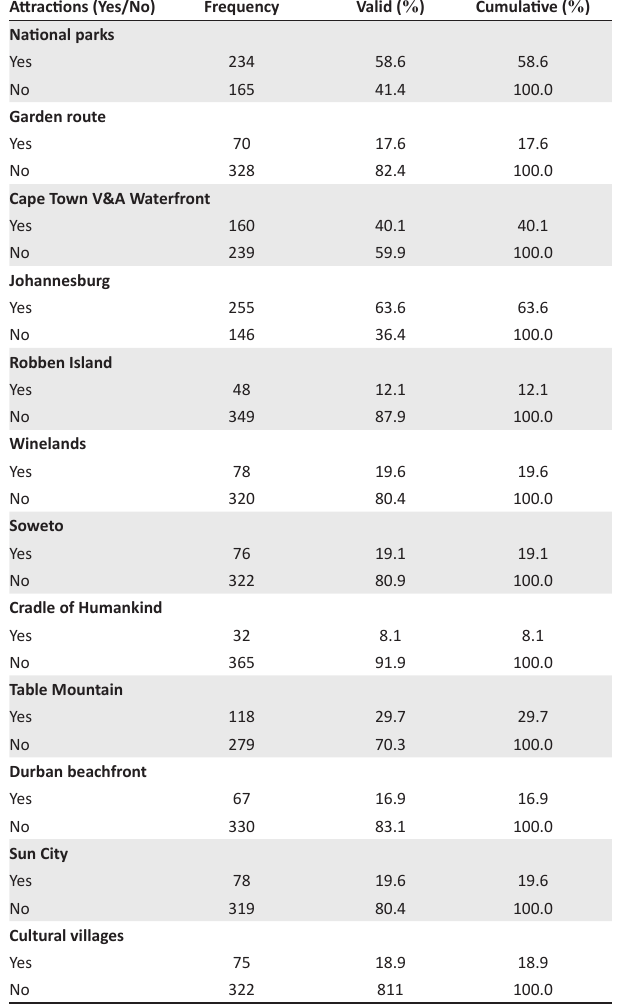
TABLE 2: Tourist